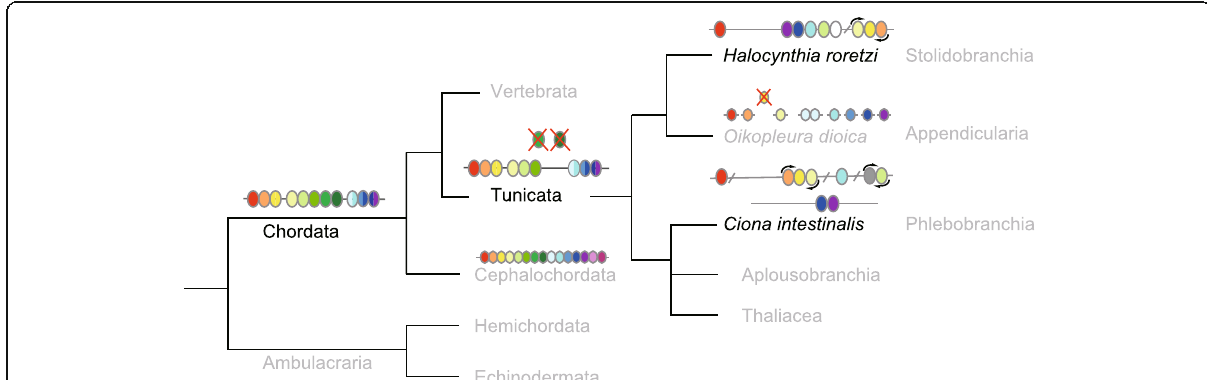
Fig. 5 A proposed scheme for Hox gene cluster disintegration during ascidian evolution. The last common ancestor for cephalochordates, tunicates, and vertebrates (represented as Chordata) possessed a single Hox gene cluster consisting of three anterior (red, orange, and yellow), five central (green) and three ancestral posterior genes (blue). After the ancestral cephalochordate diverged, the tunicate ancestor (represented as Tunicata), in turn, diverged from the vertebrate lineage. At this stage, the ancestral tunicate must have experienced extensive changes in the genome, and the Hox gene cluster disintegration started, losing one or two central Hox genes. The ancestral tunicate subsequently evolved into two lineages, and in turn, diverged into Stolidobranchia and Appendicularia lineages (right side, upper) and Phlebobranchia, Aplousobranchia and Thaliacea lineages (right side, lower) [27]. The Hox gene complement of the ancestral tunicate with each three of anterior, central and posterior genes must have been established by the divergence of the two evolutionary lineages stated above. At the same time, early Hox gene cluster disintegration events must have occurred. In one of the two resultant evolutionary lineages, the ancestral stolidobranchial ascidian ( Hr ) emerged, being separated from the larvacean lineage. In the other evolutionary lineage, the ancestral phlebobranchial ascidian ( Ci ) emerged, being separated from Aplousobranchia and Thaliacea lineages. The Hox gene cluster subsequently disintegrated in different patterns in the two evolutionary lineages. White or gray ovals indicate Hox genes, probably of the central Hox gene group origin (see text). The Hox gene complement of Oikopleura dioica , consisting of two anterior, one central, and six posterior genes, and that of amphioxus, consisting of 15 members, are schematically